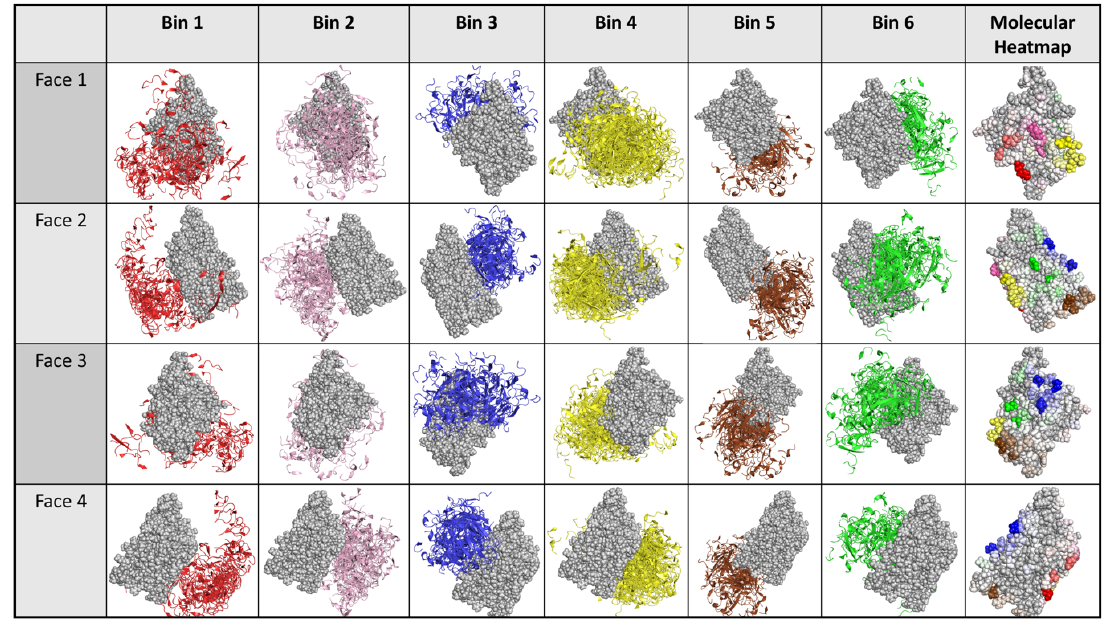
Figure 8. Binned experimentally-focused docking models for Abs vs. gD2. The same representation as Figure 4, but based on docking models that were focused according to experimental data.